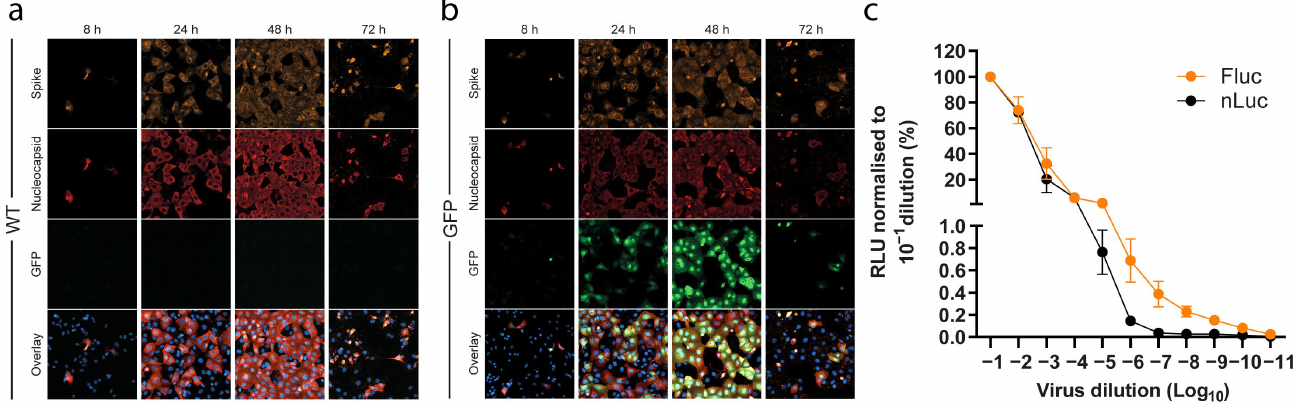
Figure 2. Clone reporter systems for SARS-CoV-2. ( a , b ) Representative images of SARS-CoV-2 Spike, SARS-CoV-2 Nucleocapsid, and GFP channels, together with an overlay of all channels including the nucleus, from a time-course infection experiment (MOI 0.01) of ( a ) wild-type clone (WT) and ( b ) GFP-reporter viruses, taken with a 40× objective. ( c ) Titration of nLuc and Fluc reporter activity of SARS-CoV-2 reporter viruses with initial infectivity titers of 5.5 and 5.3 Log TCID 50 /mL, respectively. The values of relative light units (RLU) measured at 24 h were subtracted from negative control wells and normalized to the values obtained from the 10 −1 virus dilution. The data points represent mean of quadruplicates; error bars represent standard error of the mean. For some data points the differences are too small to plot error bars.